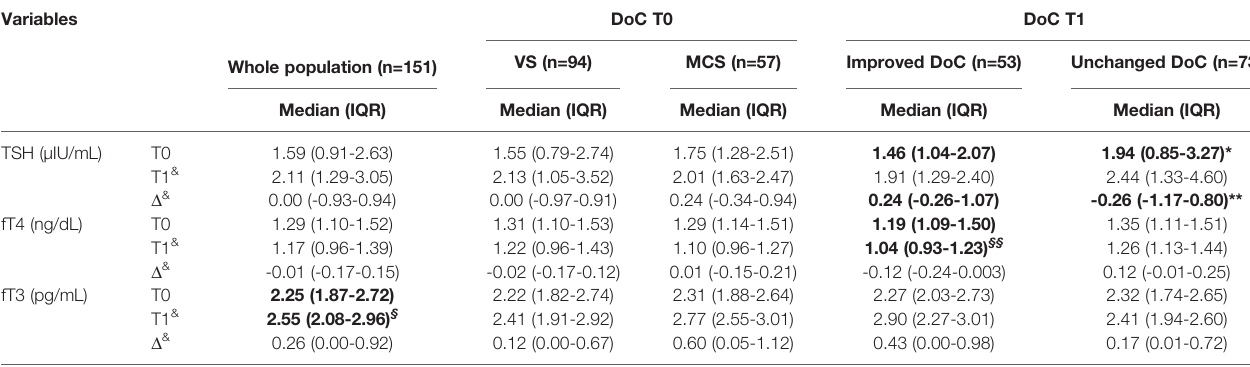
TABLE 2 | Thyroid function testing in the population as a whole and subgrouped according to DoC diagnosis on admission and at discharge.